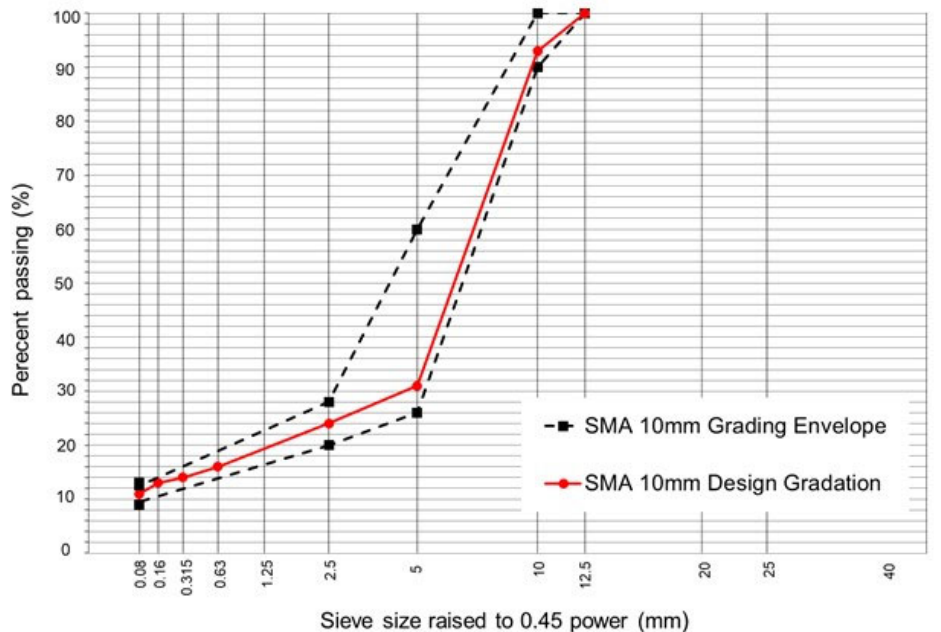
Figure 6. Design gradation of the SMA10 asphalt mixture.